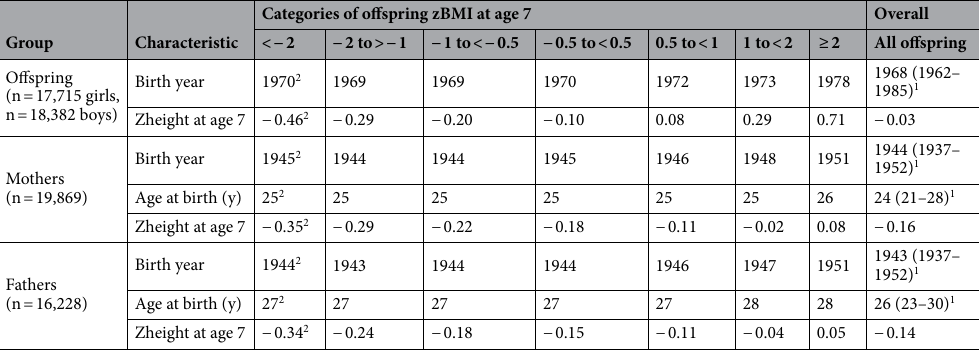
Table 1. Years of birth and parental age at birth of offspring by categories of offspring zBMI at age 7 years. 1 Median (IQR). 2